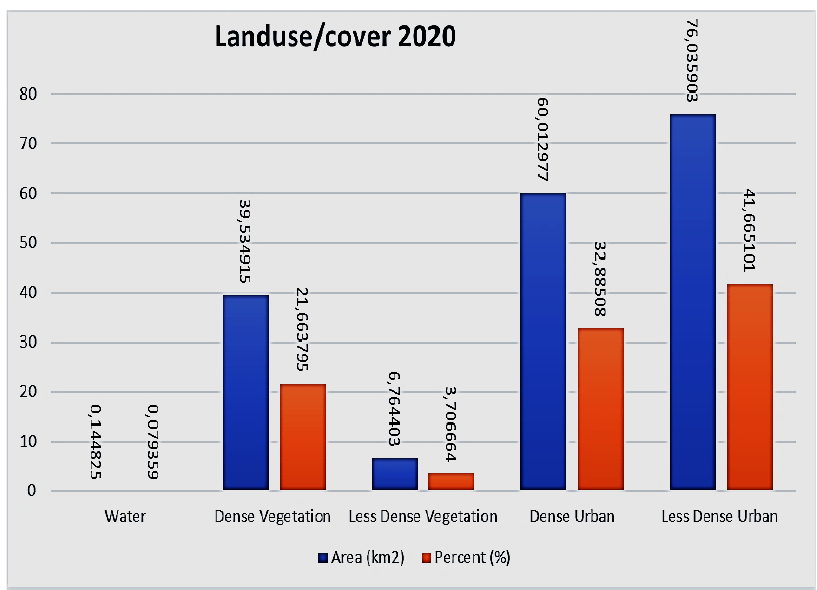
Figure 10. Land used/cover for 2020.